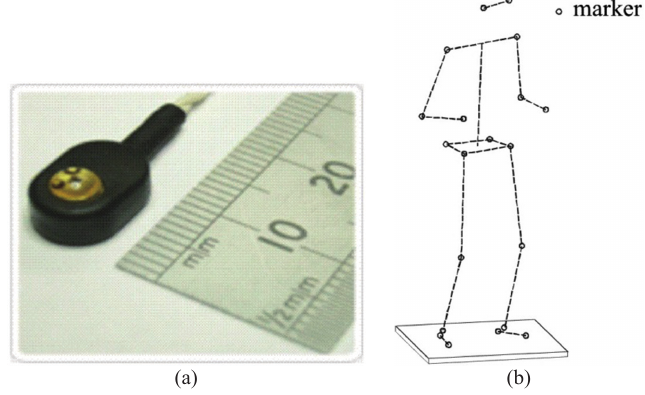
Fig. 12. (a) Motion tracking marker. (b) Body model and marker